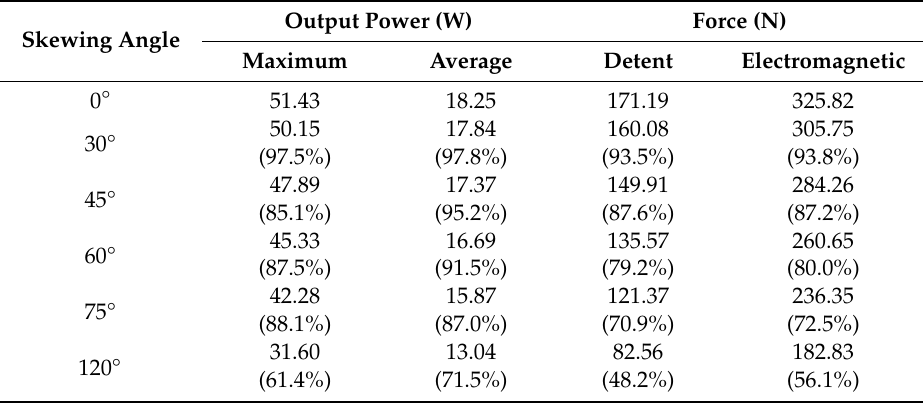
Figure 5. Detent force and electromagnetic force for different skewing angles. Table 2. Performance of the 1/8 model for different skewing angles.